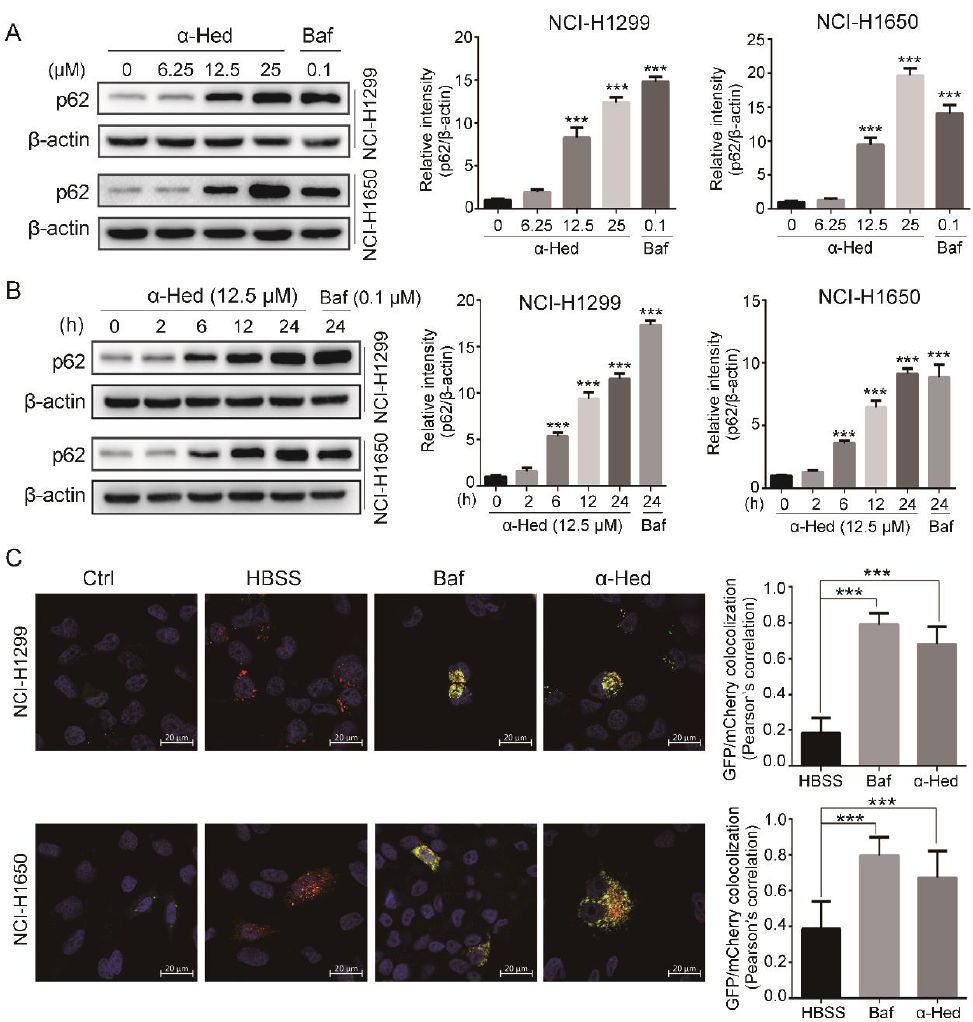
Figure 2. α -Hed inhibited autophagic flux in human NSCLC cells. ( A , B ) α -Hed promoted p62 accumulation in a dose- and time-dependent manner. NCI-H1299 and NCI-H1650 cells were treated with α -Hed (12.5 µ M) or Baf (0.1 µ M) for the indicated time courses ( B ), or treated with α -Hed or Baf at the indicated doses for 24 h ( A ). p62 was quantified and the fold increase is presented. *** p < 0.001.